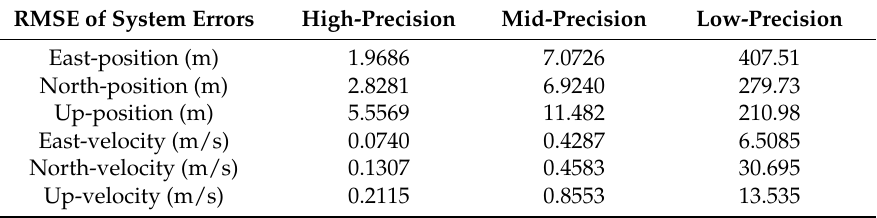
Figure 5. Comparison diagram of position error aided by the three kinds of IMUs. Table 5. RMSEs of the deeply coupled system errors aided by the three kinds of IMUs.